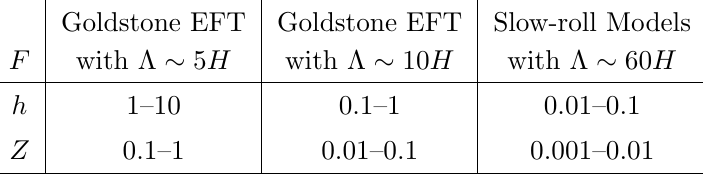
Table 8 . Summary of strength of NG mediated by h and Z